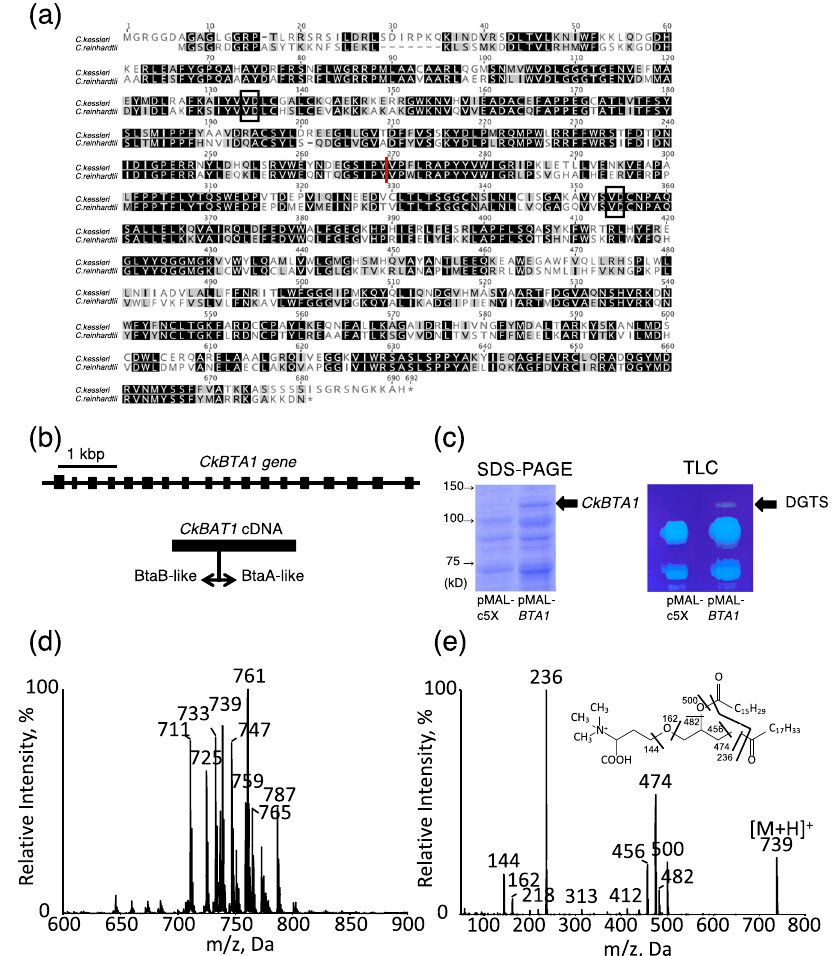
Fig. 7 Structural and functional identi fi cation of a BTA1 homolog in C. kessleri . a Alignment of the postulated amino acid sequence of a BTA1 homolog with that of CrBTA1. Identical and similar amino acid residues are shadowed in black and gray. The vertical red line indicates the boundary of the N-terminal BtaB- and C-terminal BtaA-like domains, whereas two black boxes show the conserved dipeptide VD for the binding of SAM, the substrate in the respective catalytic actions of BtaA and BtaB. b The structure of the BTA1 homolog of C. kessleri . The BTA1 homolog is composed of 18 exons on the nuclear genome. c Expression of cDNA of the BTA1 homolog in E. coli . SDS-PAGE of total cellular proteins shows induction of the expression of the homolog protein in pMAL- CkBTA1 introduced E. coli cells, but not in empty-vector introduced ones. TLC of total cellular lipids shows the appearance of a lipid speci fi cally in pMAL- CkBTA1 introduced E. coli cells. d The ESI mass spectrum of the lipid in the transformant of E. coli . e The product ion spectrum of m/z 739 in ( d ). Note that the product ion spectrum exhibited three signals ( m/z 144, 162, and 236) for identi fi cation of the lipid as